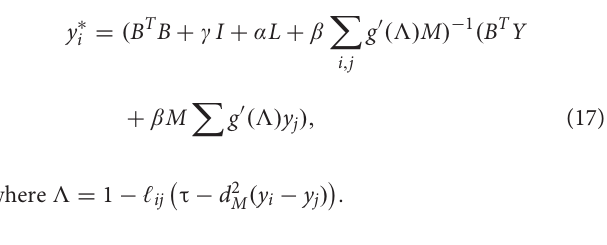
TABLE 2 | Retrieval performance of SRDML for the query image Glioma on 5-fold test set.